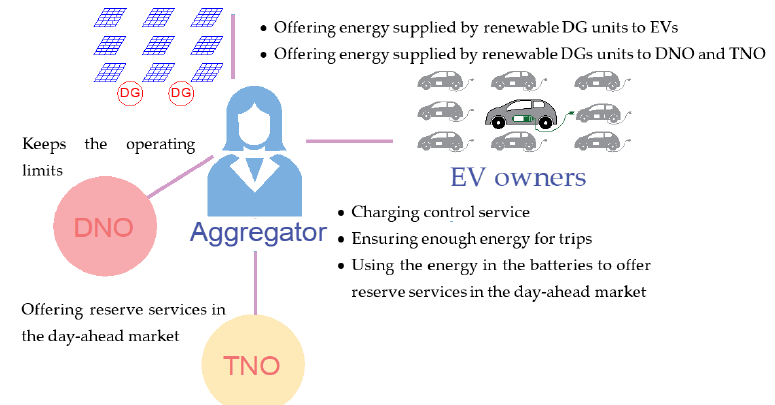
Figure 1. The role of an aggregator with the electrical power system and the DERs .